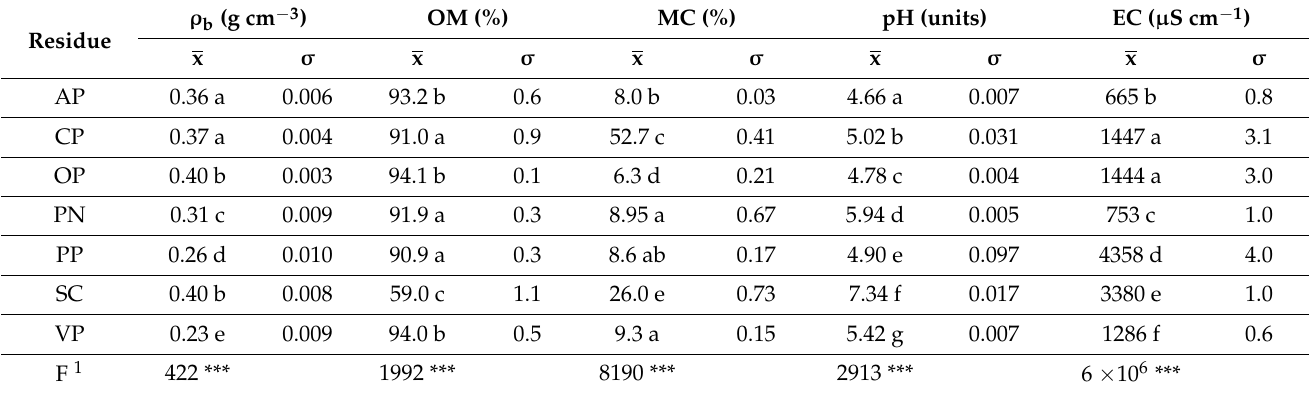
Table 2. Bulk density ( ρ b ), OM, MC, pH and EC of each residue, average (x) and standard deviation ( σ